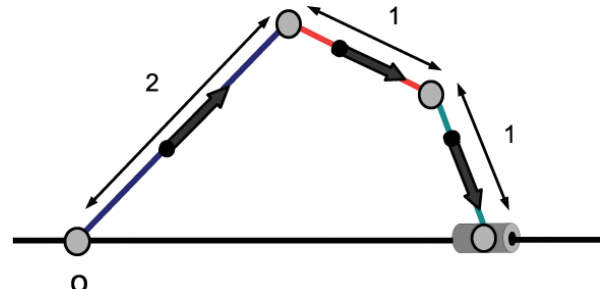
Figure 8. A slider crank